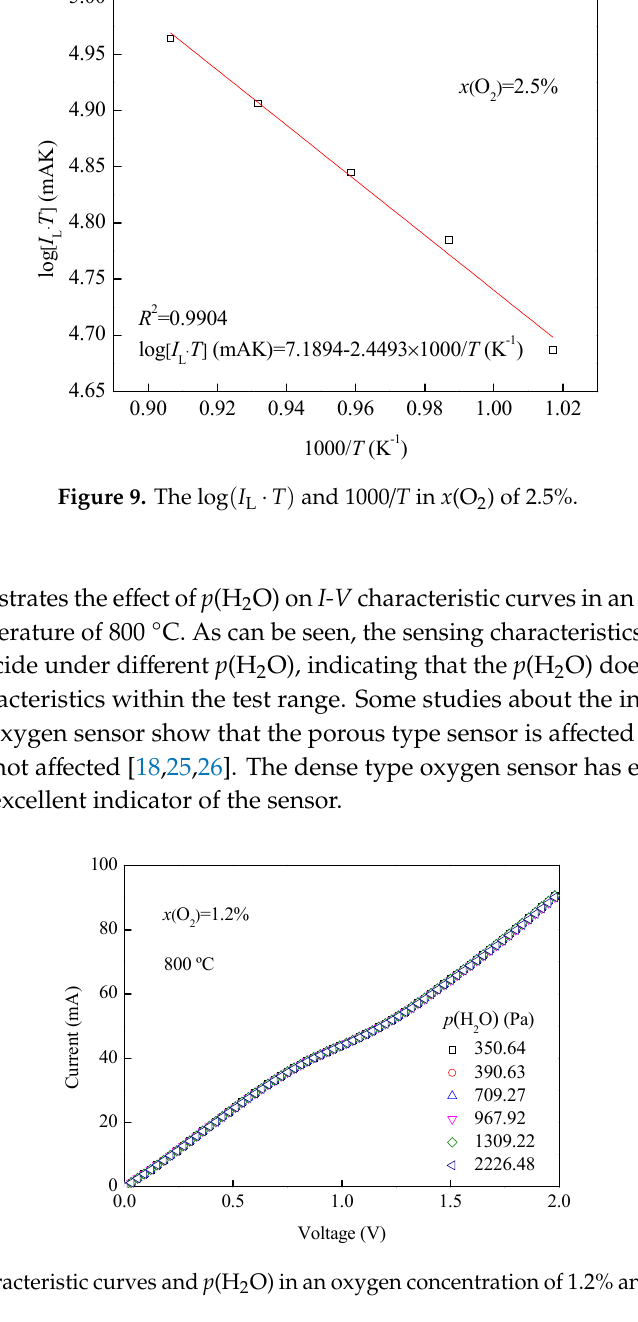
Figure 10. I-V characteristic curves and p (H 2 O) in an oxygen concentration of 1.2% and at a temperature of 800 °C.